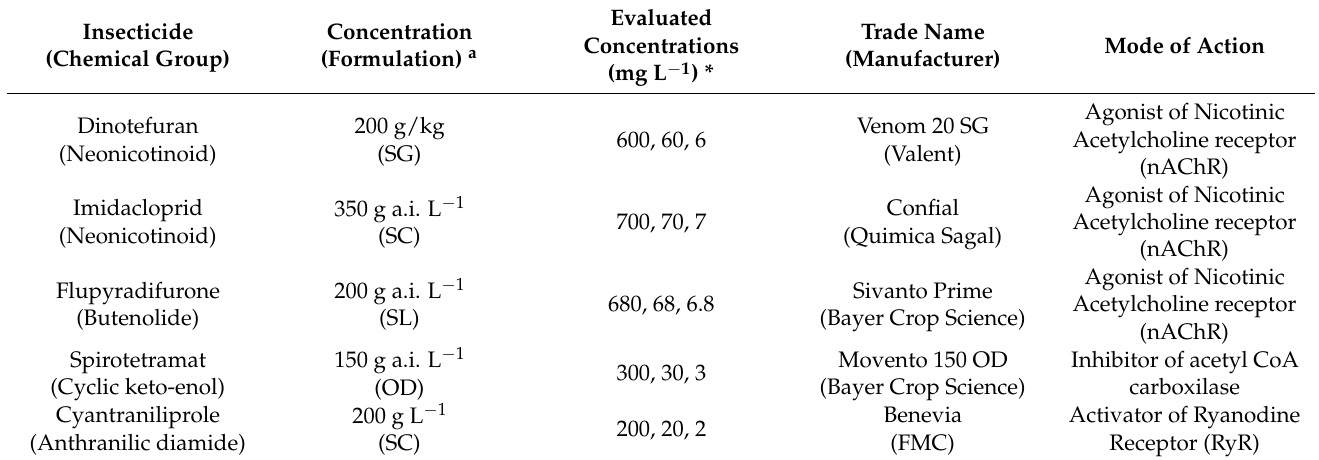
Table 1. Details of the insecticides evaluated in the present